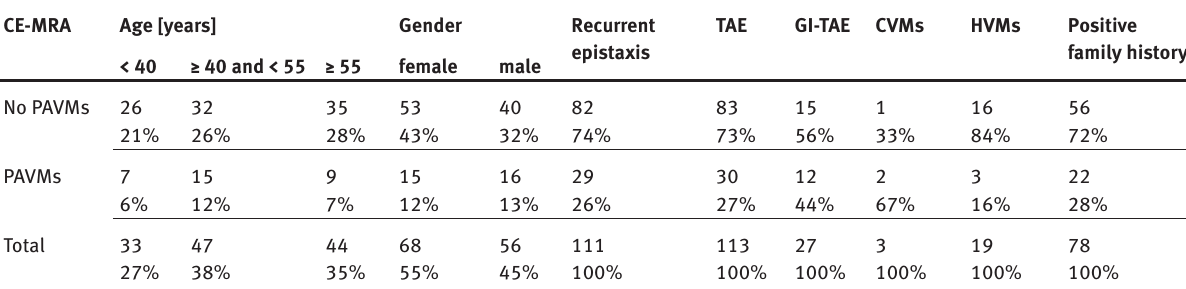
Table 4: Age, gender, other manifestations and positive family history